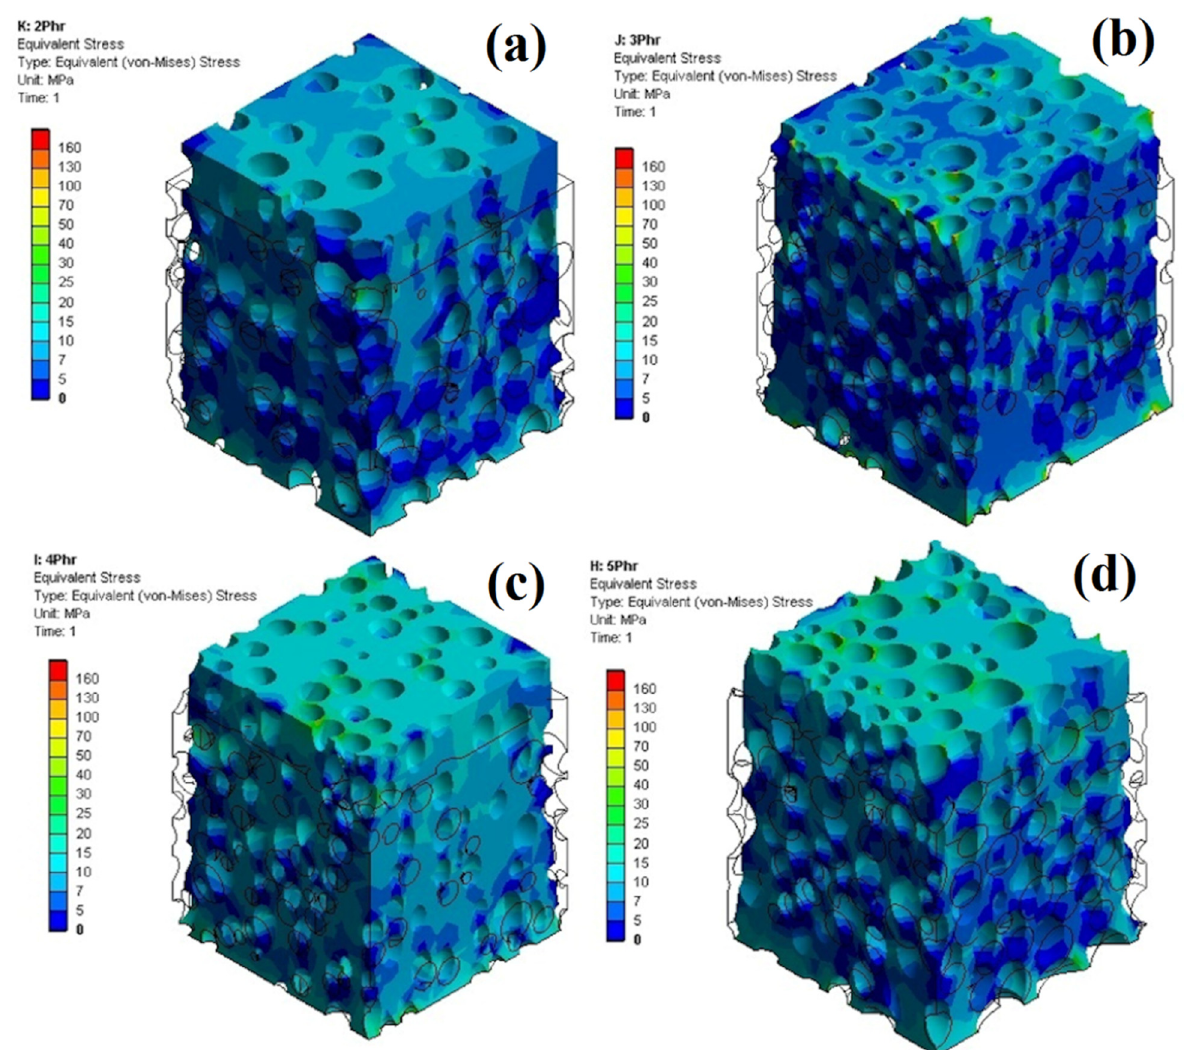
Figure 11. Maximum stress during uniaxial tension for POE foams with different ADC contents: ( a ) 2 phr, ( b ) 3 phr, ( c ) 4 phr and ( d ) 5 phr.